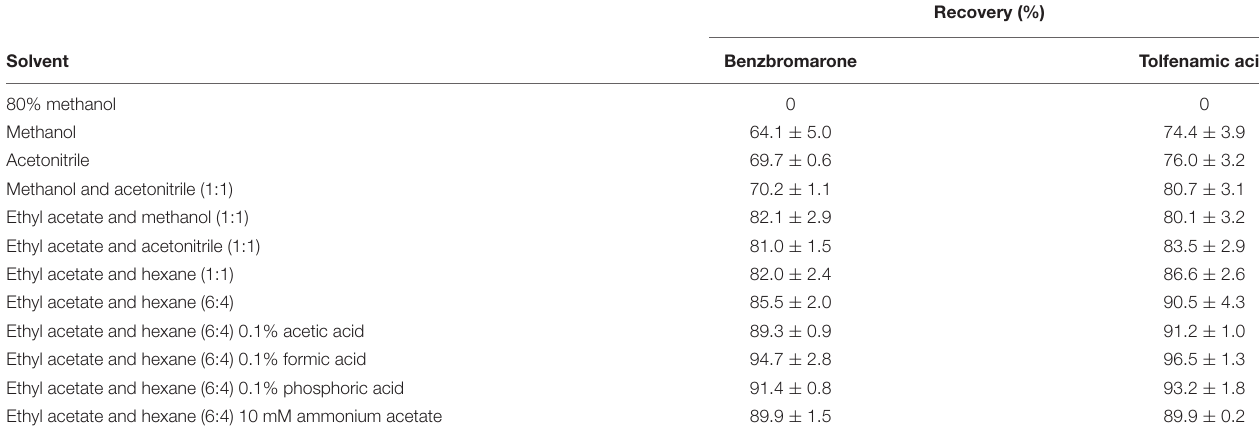
TABLE 2 | LC-MS/MS operating